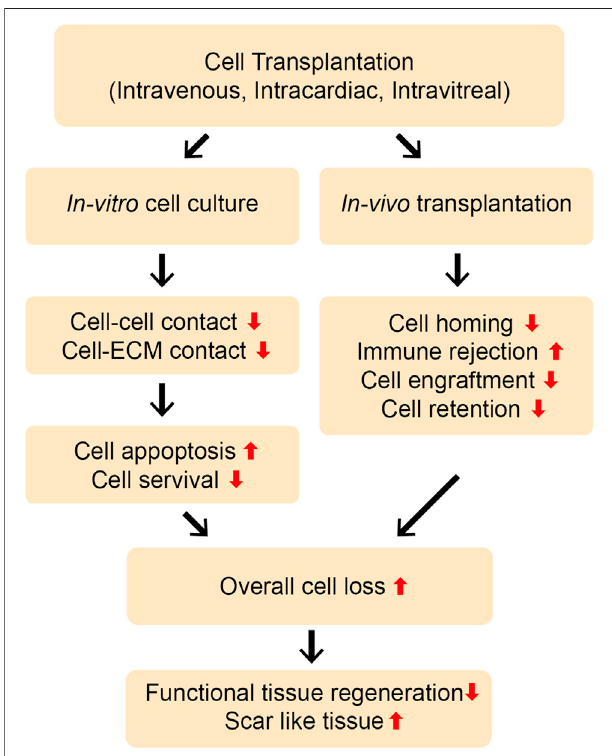
FIGURE 1 | Limitations of direct cell transplantation. Cells can be transplanted in vivo by different routes, such as intravenous, intramuscular, intra-cardiac,orintra-vitreousinjection.Thedirecttransplantationofstemcells and progenitor cells without using biomaterial platforms may lead to the poor cell-cell and cell-ECM interactions, resulting into the severe loss of the cells through apoptosis in vitro and in vivo . Moreover, the cells canexperience rapid loss upon transplantation in vivo due to poor cell survival, retention, and engraftment at the injury site. Poor cell homing and immune rejection may further aggravate this problem. Overall, this can lead to severe cell loss and less functional, more scar-like tissue repair.